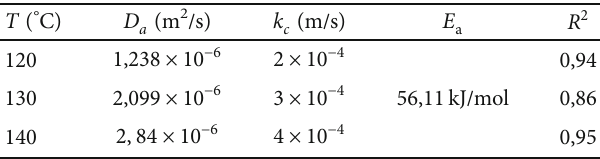
Figure 2: Logarithm of the dimensional moisture concentrations of the Coastal Carimañolas vs . the frying time for each temperature. Table 2: Parameters of mass transfer of vacuum-fried Coastal Carimañolas: di ff usivity and convective moisture coe ffi